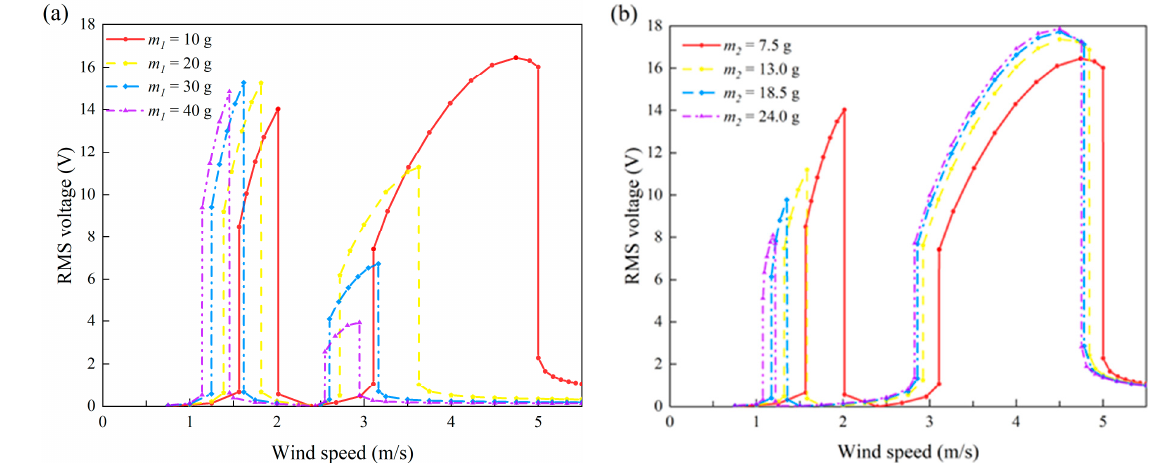
Figure 22. Effects of masses on the RMS voltage of the 2DOF VIVPEH: ( a ) m 1 ; ( b ) m 2 .